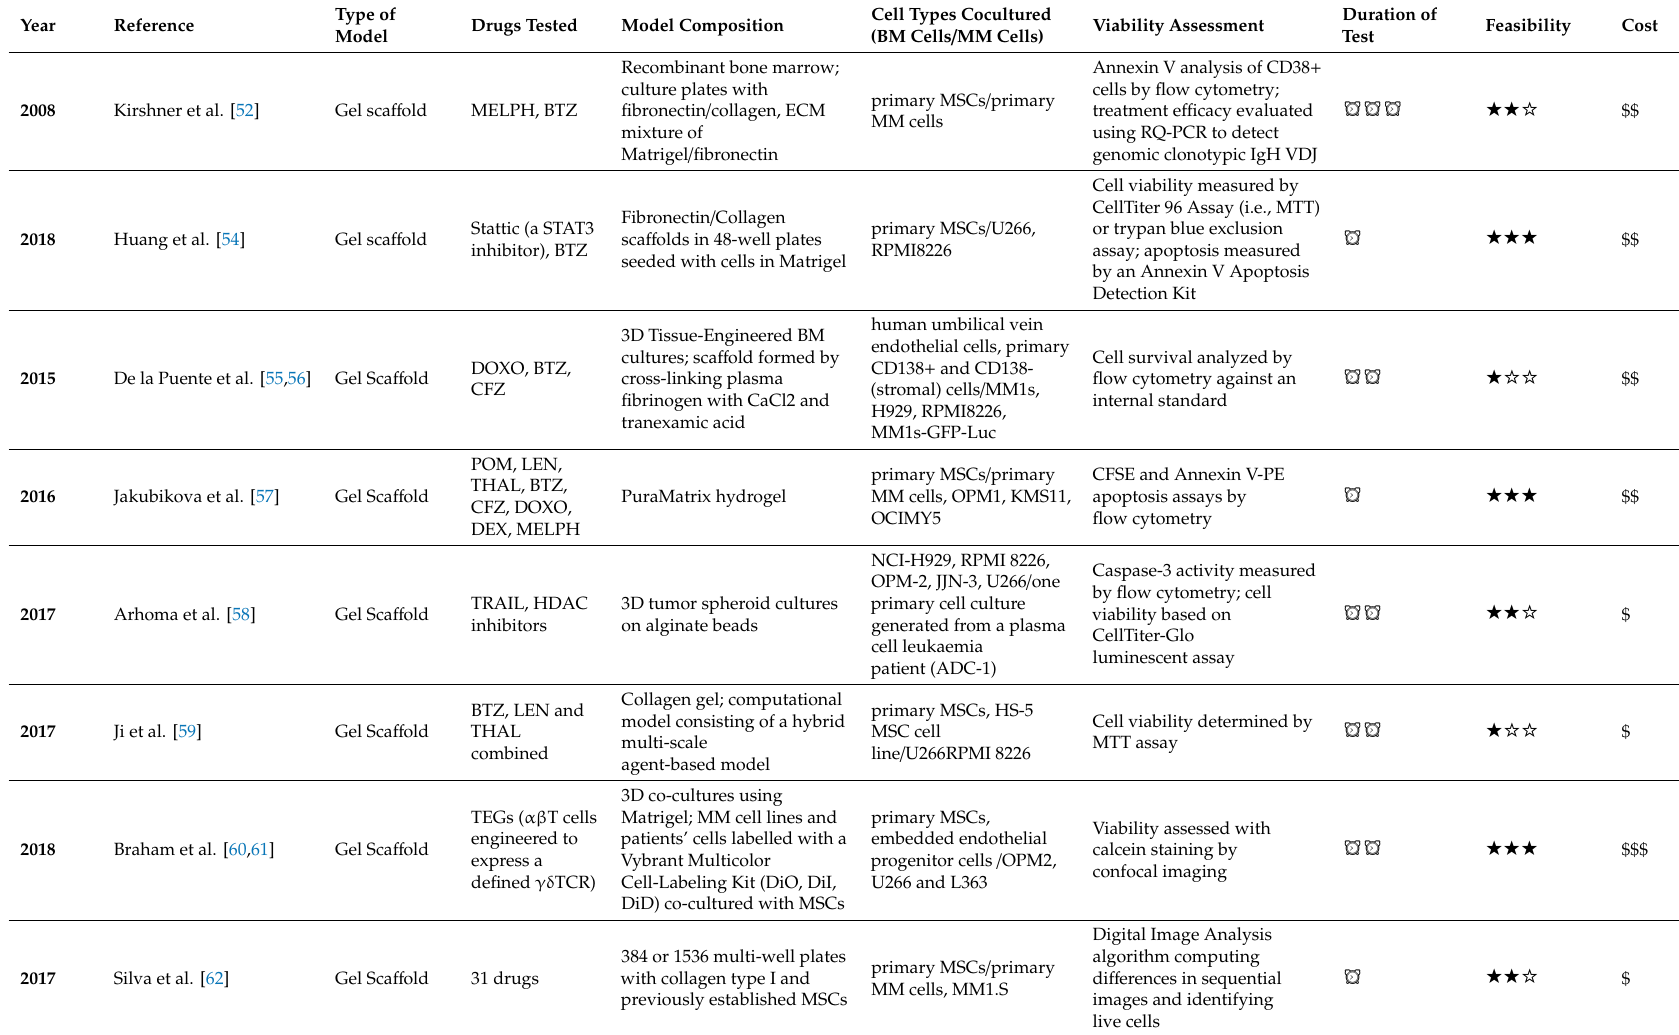
Table 1. Selected ex vivo 3D models simulating the bone marrow environment of multiple myeloma (MM) patients.